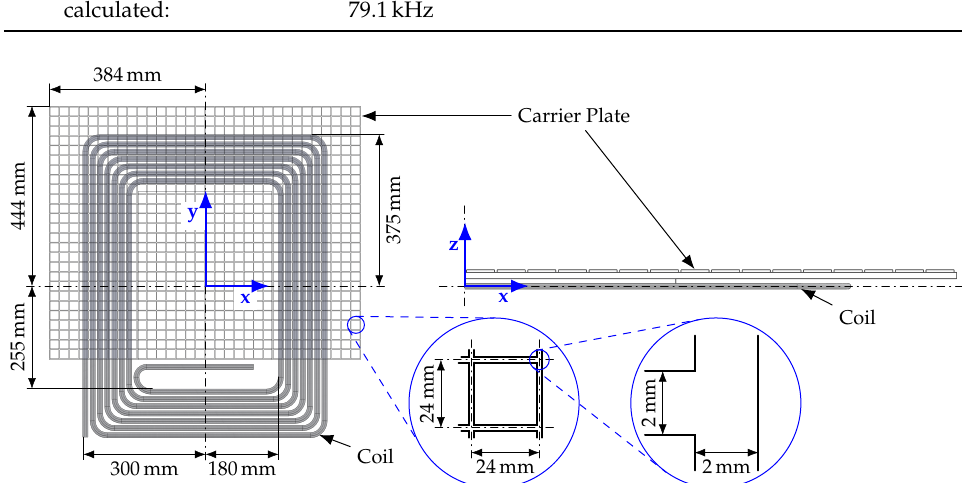
Figure 1. Ground assembly coil, carrier plate for sensor coils and defined system of